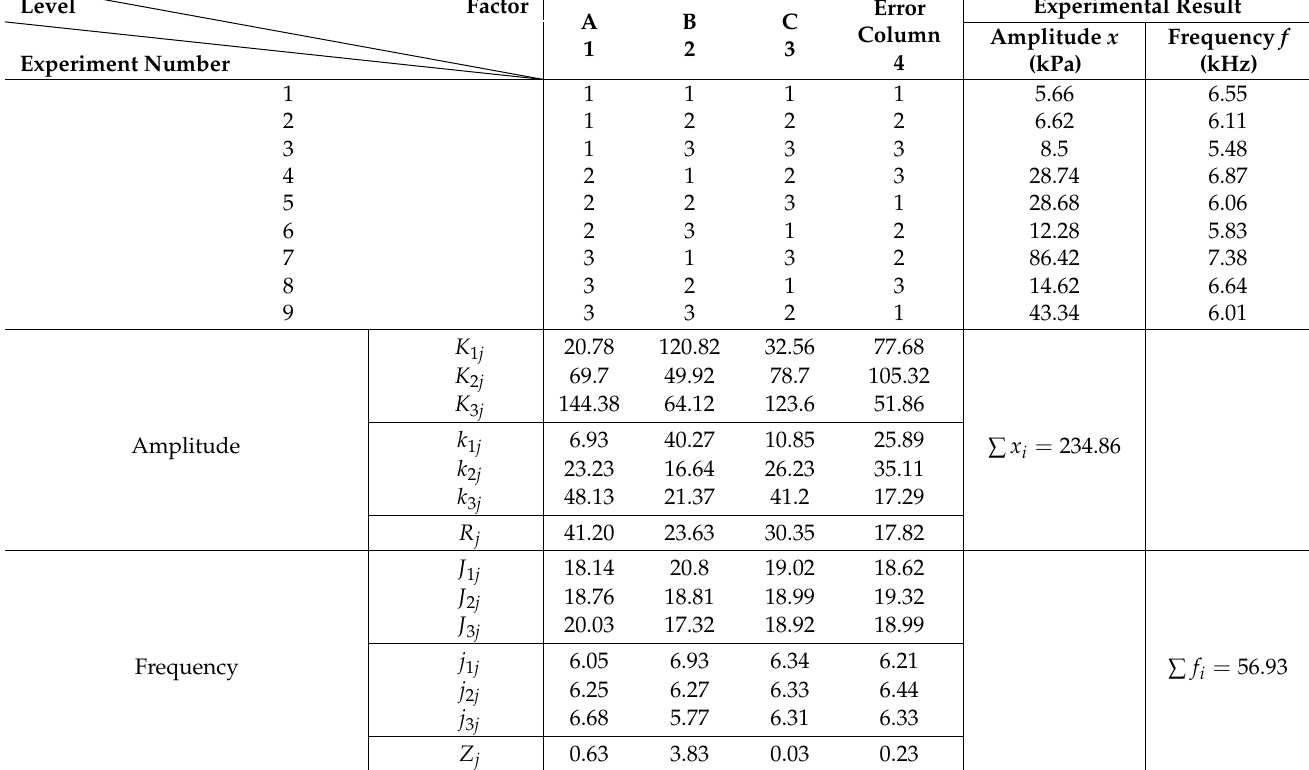
Figure 6. Sound pressure curve of fuze airflow-induced acoustic generator. ( a ) Sound pressure amplitude; ( b ) Sound pressure spectrum.